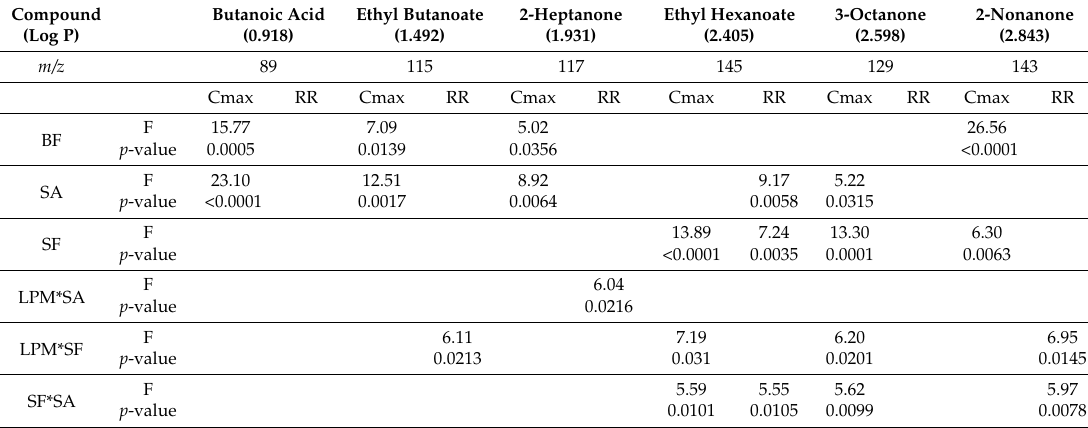
Table 4. In vitro aroma compound release from lipoprotein matrices. Fisher statistics from Analyses of Variance (ANOVA) of the temporal aroma compound release parameters. Only significant